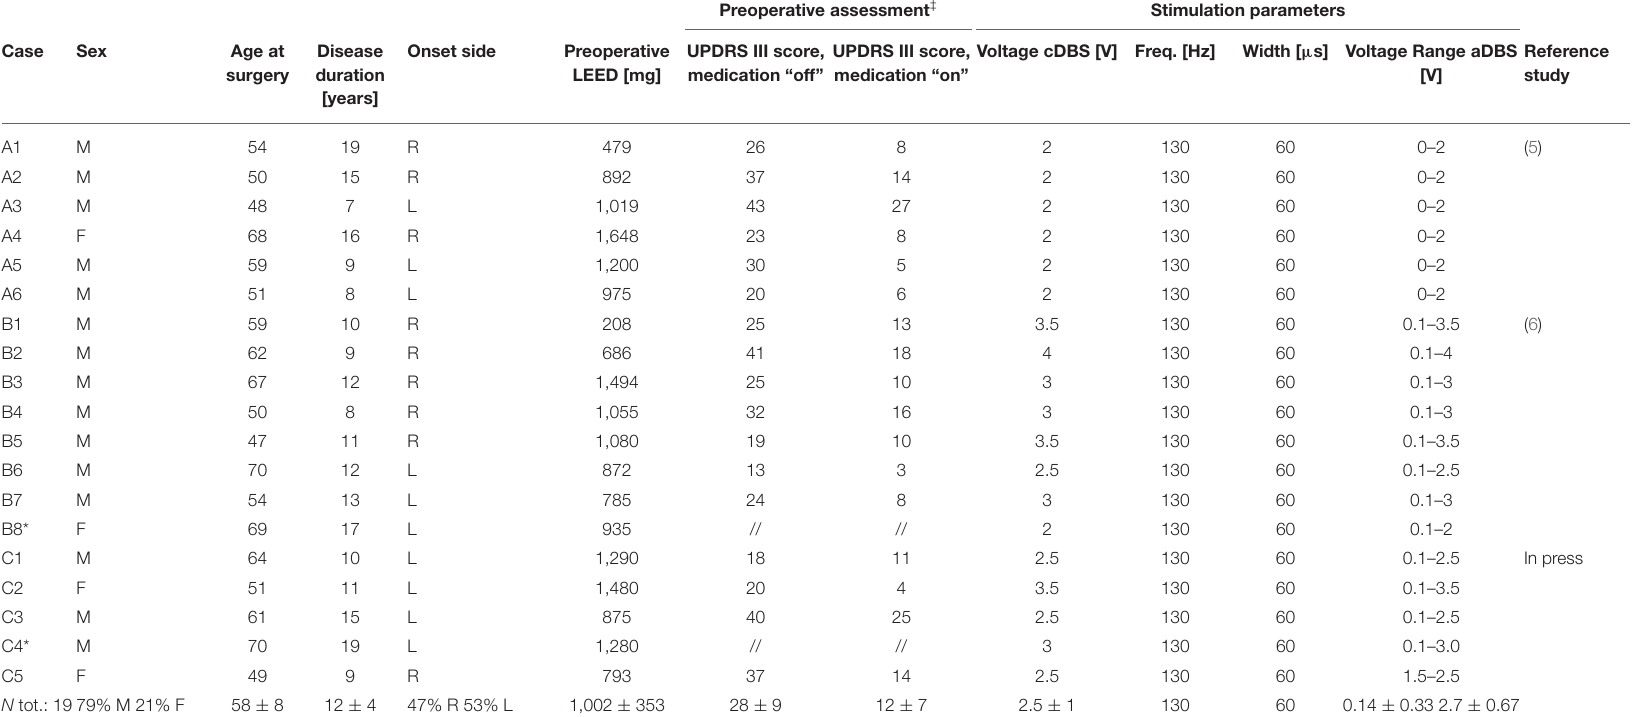
TABLE 1 | Patient’s clinical